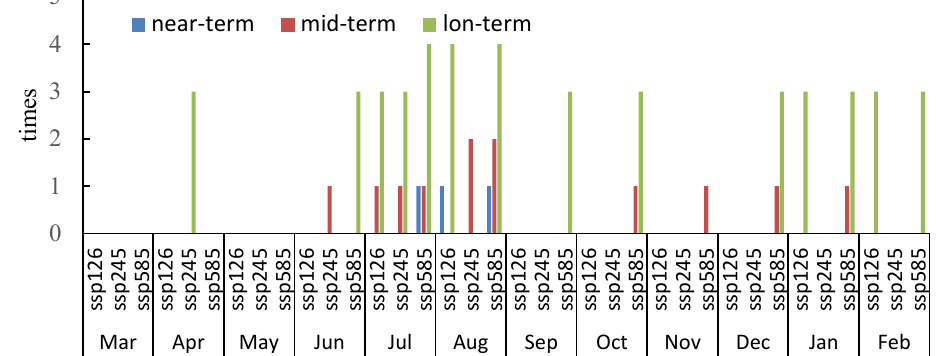
Figure 4. The number of hydrological droughts (SRI-12) exceeding the historical maximum intensity for the near-, mid-, and long-term periods under the SSP1–2.6, SSP2–4.5, and SSP5–8.5 scenarios.